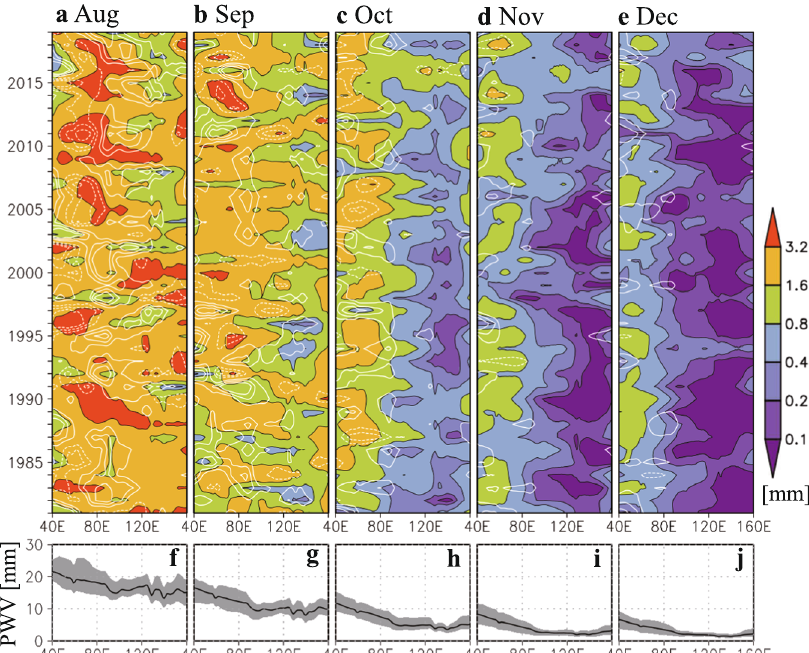
Fig. 2 Distribution of water vapor evaporated from Arctic Ocean. a – e Longitude – time cross section of monthly mean water vapor amount evaporated from the Arctic Ocean (shading; mm) averaged along the coastal inland area (see Fig. 1). Contours indicate meridional component of water vapor fl ux including all moisture sources. Contour interval is 20 kg m − 1 s − 1 (omitting zero), and the solid and dashed lines represents poleward and equatorward transport, respectively. f – j Longitudinal distribution of climatological (1981 – 2019) monthly averaged precipitable water vapor (mm). Shading denotes highest and lowest values during the study